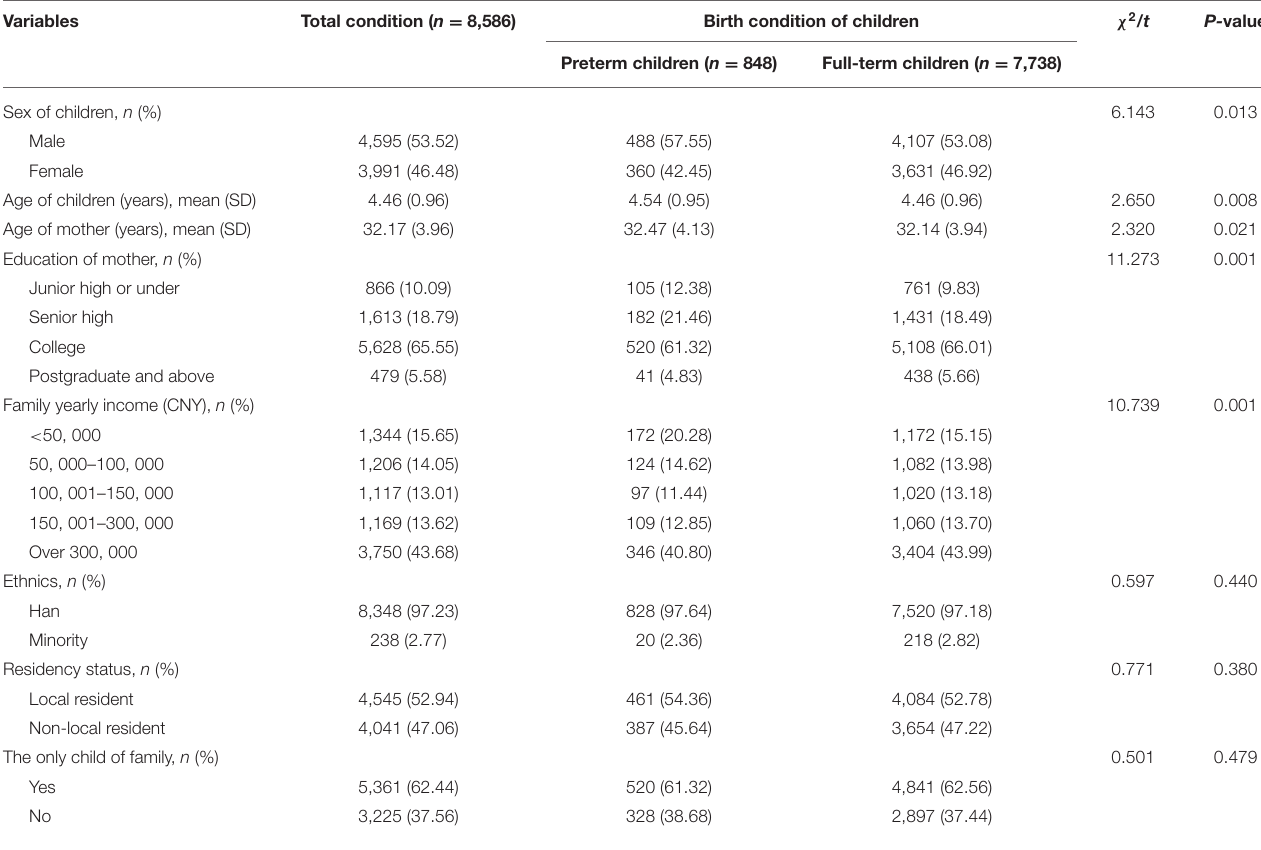
TABLE 1 | Demographic feature of kindergarten children and their mothers in a rural area of Shanghai, China.